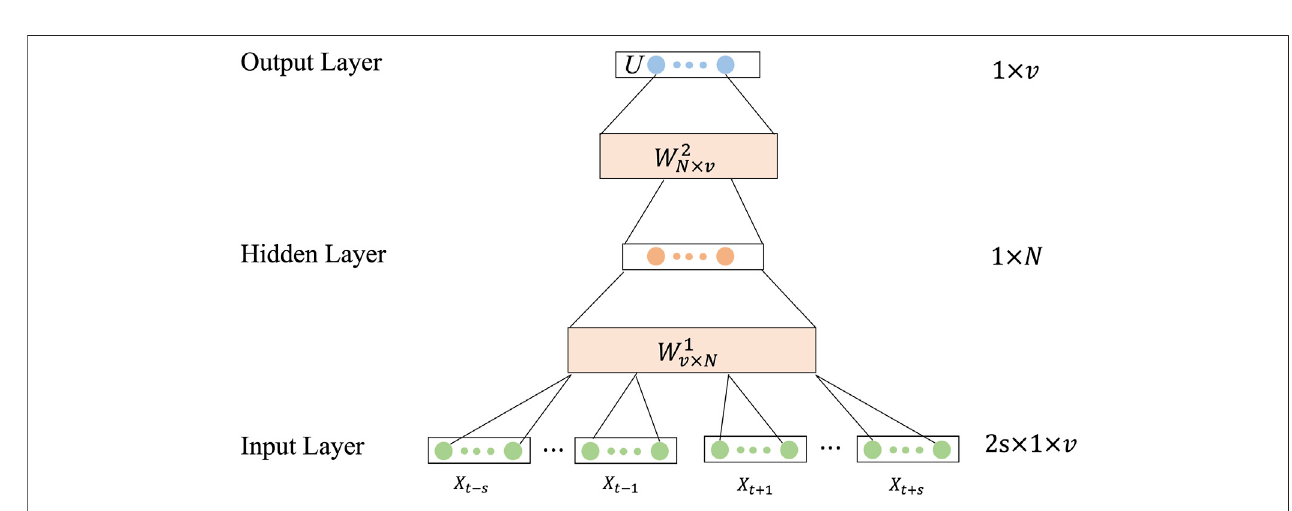
FIGURE 3 | The structure of CBOW.